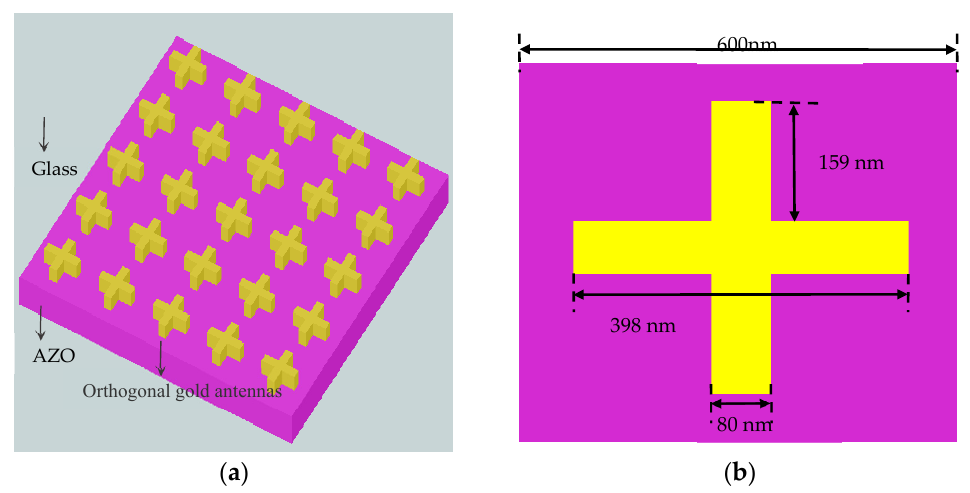
Figure 1. Structure ( a ) The structure shows—from top to bottom—gold orthogonal nanoantennas with height 25 nm, AZO nanolayer with height 22.5 nm, glass ( b ) Planar structure of the gold orthogonal nanoantennas, the distance (600 nm) of the two adjacent orthogonal antennas.